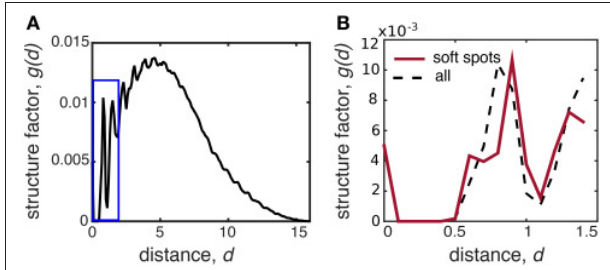
FIGURE 13 | The structure factor g ( d ) helps explain why local coordination predicts location of soft spots. (A) The structure factor g ( d ) shows short range order (peaks for d . 3), but generally no long-range order. (B) Zooming in on the blue boxed region from (A) , we see differences in local structure between bucklers in soft spots (red solid line) and the averaged aggregate (black dashed line). All data is generating by averaging over 10 independent simulation